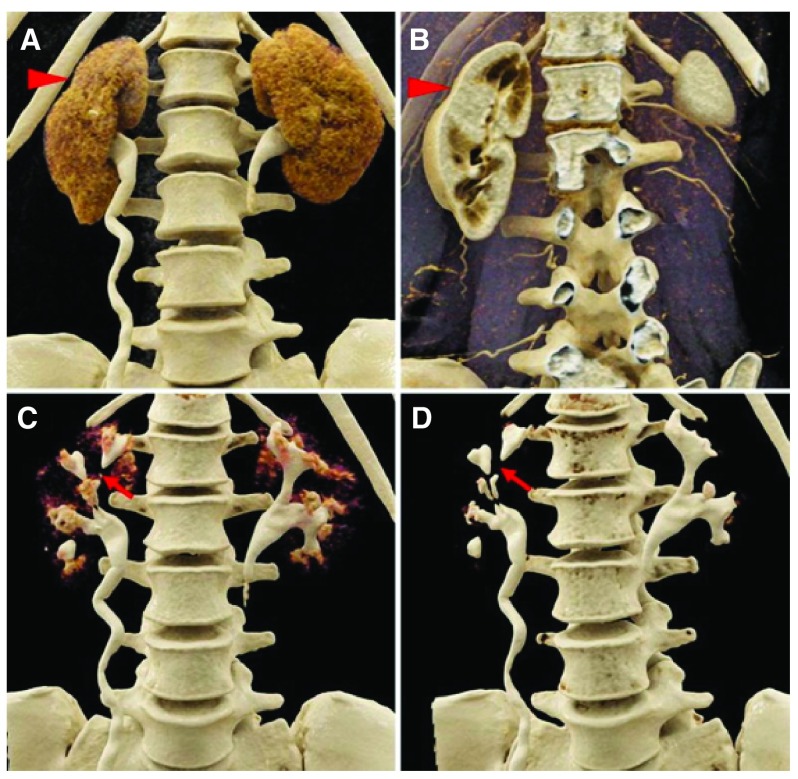
Cinematic rendering of a computed tomography image of a scarred kidney.Coronal, contrast-enhanced computed radiography visualizations of a 42-year-old woman with a history of recurrent urinary tract infections. With soft tissue window settings in the
A) excretory/urographic and
B) arterial phases, contour abnormalities in the right kidney that correspond to regions of scarring are apparent (red arrowheads).
C,
D) During the excretory/urographic phase of this study, the windowing can be adjusted to optimize the visualization of the collecting systems and ureters. In the right kidney, note the extensive irregularities of the collecting system, including multiple calyceal strictures (red arrows). Reproduced with permission from Rowe
et al.
14.